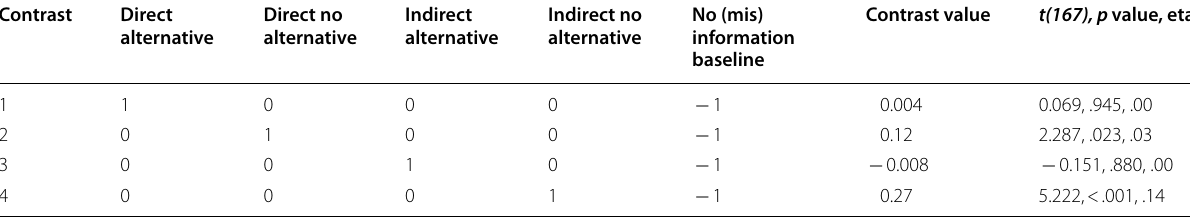
One-way ANOVA, F (4, 167)